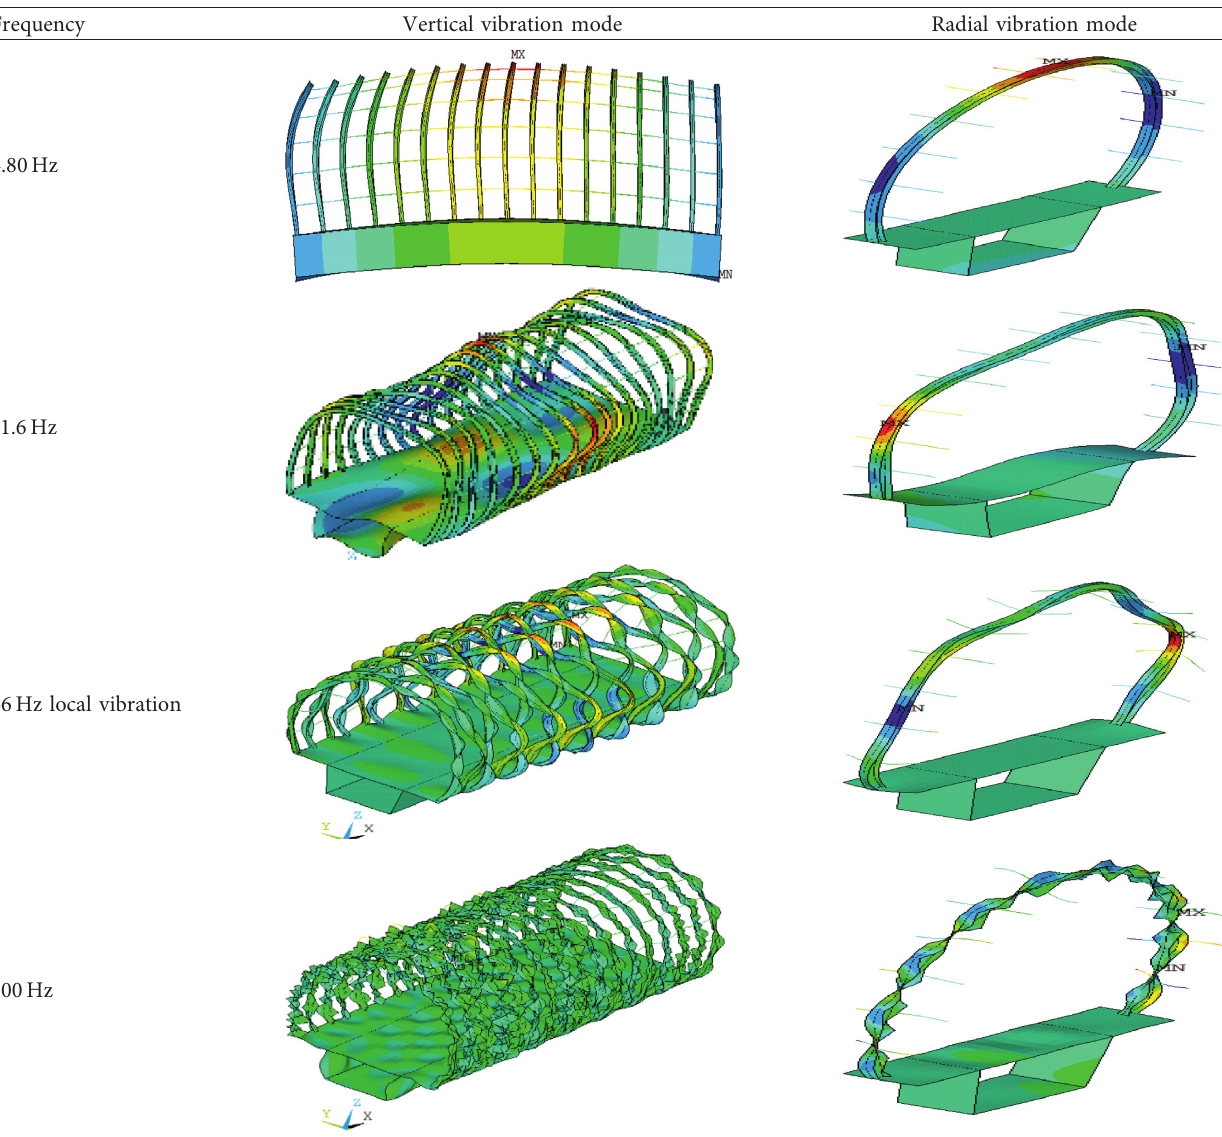
Table 3: Typical vibration modes of the bridge sound